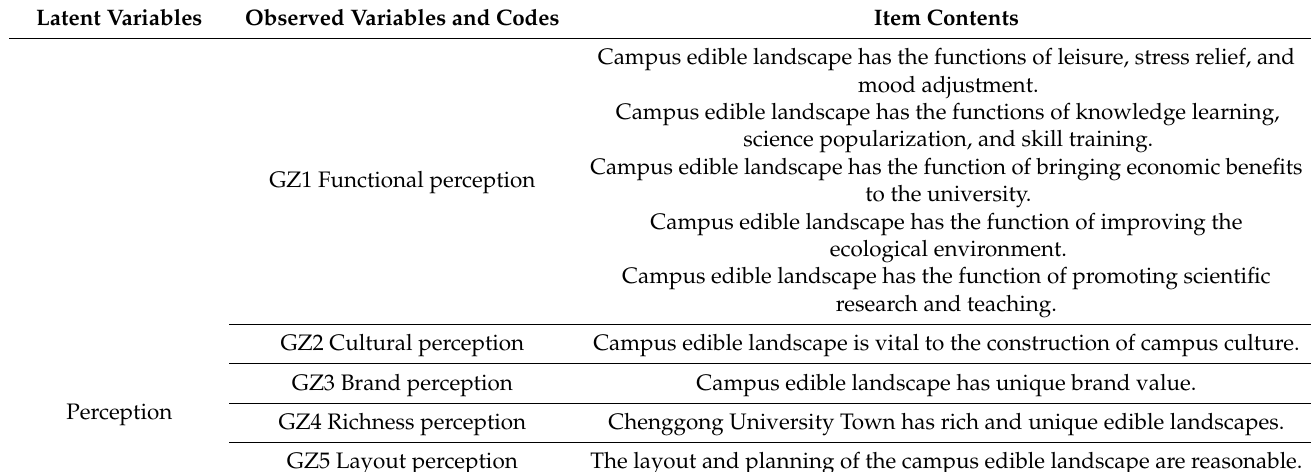
Table 2. Questionnaire